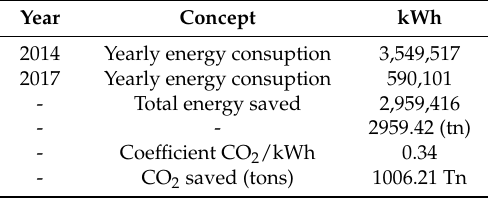
Table 8. Direct reduction of CO 2 (LED).